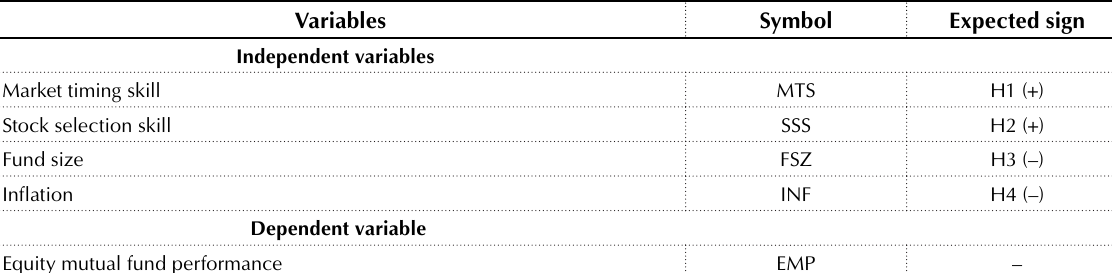
Table 1. Research variables and